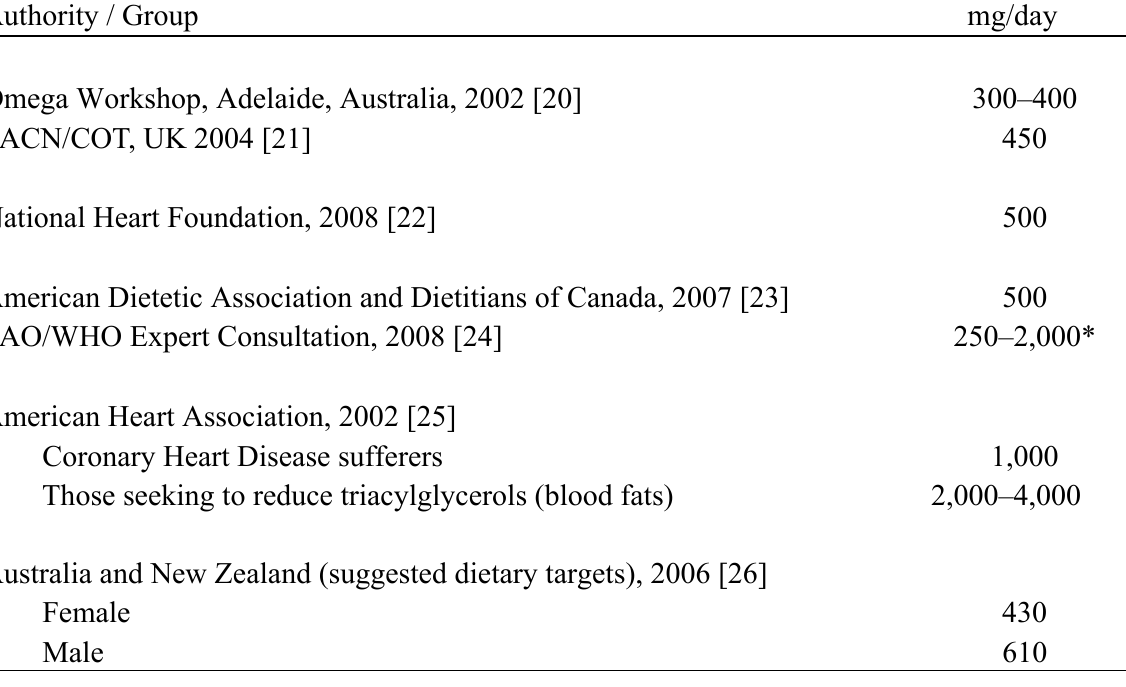
Table 3 . Selected suggested LC omega-3 (EPA + DHA) intakes for adults available from various agencies and